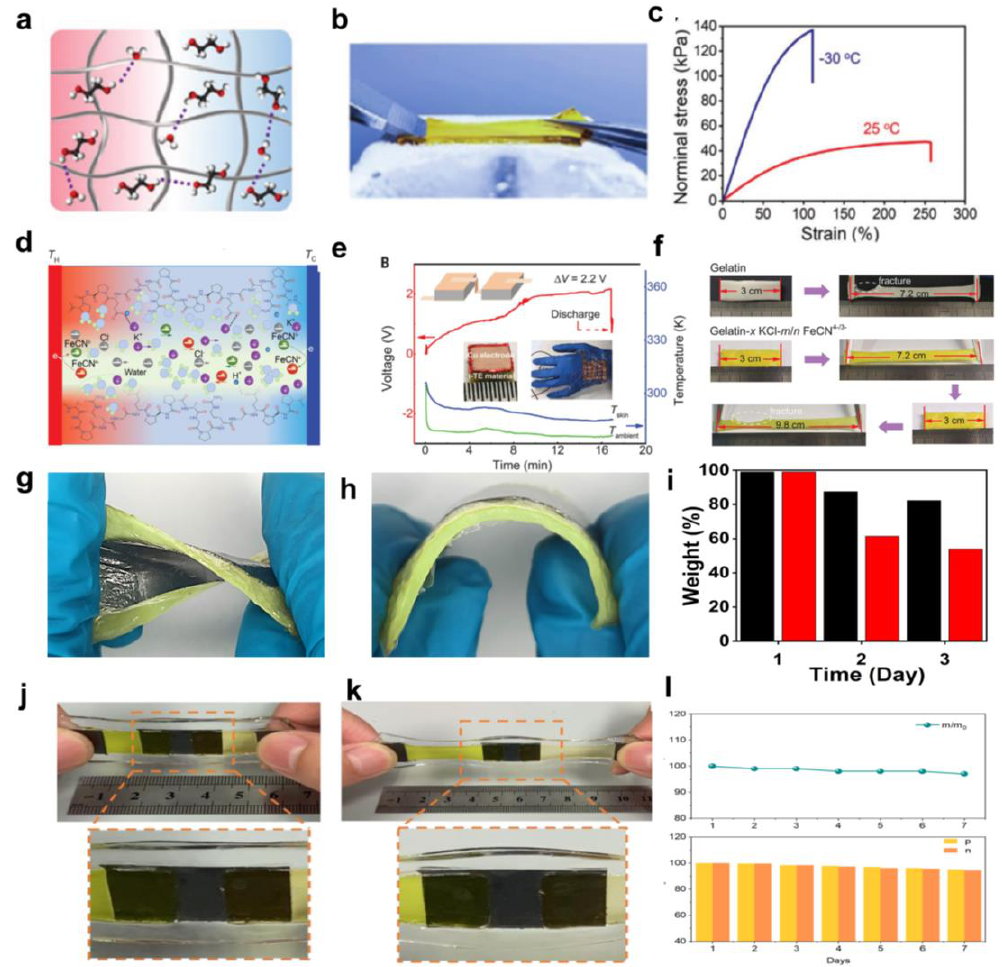
Figure 9. ( a ) Schematic illustration of the organohydrogel thermocell containing crosslinked networks, EG, and water upon a temperature gradient. The additional EG can disrupt the ice crystal lattice to expand the working temperature at subzero temperatures. ( b ) A photograph of the organohydrogel thermocell being stretched on an ice surface of 20 ◦ C). ( c ) The tensile curves of the organohydrogel thermocell in ambient (25 ◦ C) and cold ( − 30 ◦ C) environments. Giant thermopower of i-TE materials (Reproduced with permission from [82]. Copyright 2021 Wiley-VCH GmbH). ( d ) Schematic figure of the diffusion, redox reaction, and interaction of the ions in the as-fabricated i-TE materials of Gelatin-x KCl − m/n FeCN 4 – /3 – under the temperature gradient. ( e ) The voltage generated from a proof-of-concept flexible i-TE wearable device with 25 unipolar elements (Cu | i-TE | Cu, 5 × 5 × 1.8 mm, smooth Cu foil) in series worn on the back of the human hand. ( f ) Tensile test of the i- TE material of Gelatin-0.8 M KCl-0.42/0.25 M FeCN 4 – /3 – (rv = 2.0) compared with pure gelatin. (Re- produced with permission from [85]. Copyright 2020, AAAS.). ( g , h ) Photographs of the gel patch that was twisted and bent. ( i ) Dehydration of the gel thermoelectric patch (Black)and commercial fever-reducing patch (Red). (Reproduced with permission from [118]. Copyright 2021 American Chemical Society). ( j , k ) Photos of graphite electrode connected p-n cell in original ( left ) and stretch- able ( right ) state. ( l ) The water retention rate and Seebeck coefficient retention rate of p- and n-type hydrogel encapsulated by VHB tape. (Reproduced with permission from [55]. Copyright 2022 Wiley-VCH GmbH).